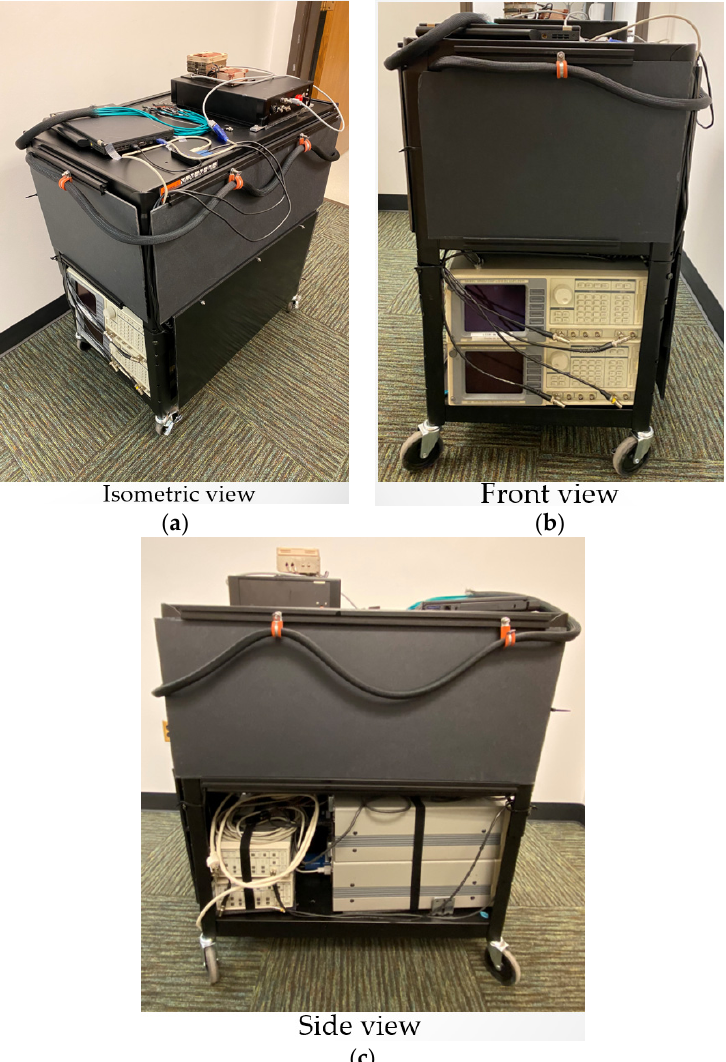
Figure 22. Pictures of SCISCCO prototype: ( a ) isometric, ( b ) front, and ( c ) side views. A detailed block diagram of the optical system and hardware layout (i.e., the middle level of the cart) is provided in Figure 23. The output from the SC laser is coupled via a